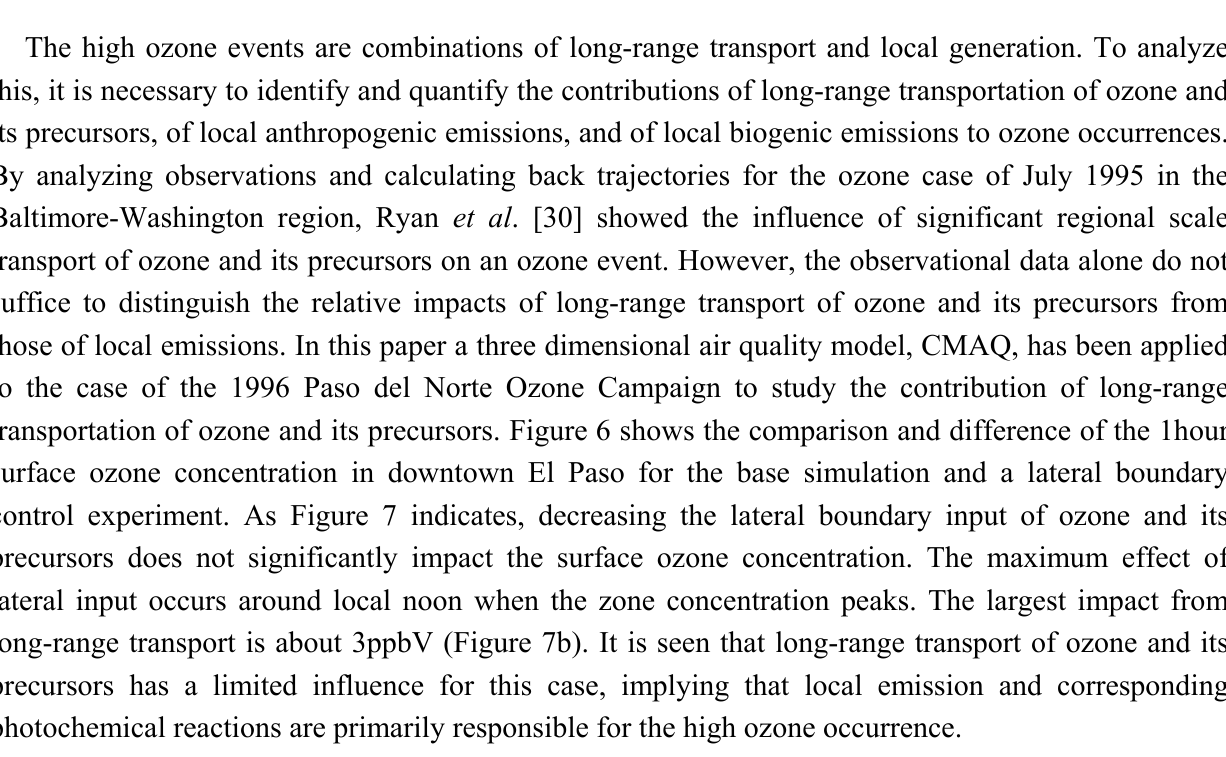
Figure 7. (a) Surface ozone concentration comparison and (b) the difference between base simulation and controlled experiment for lateral boundary input of ozone and its precursors at the location of downtown El Paso during the period from 1200Z 13 August to 1200Z 14 August